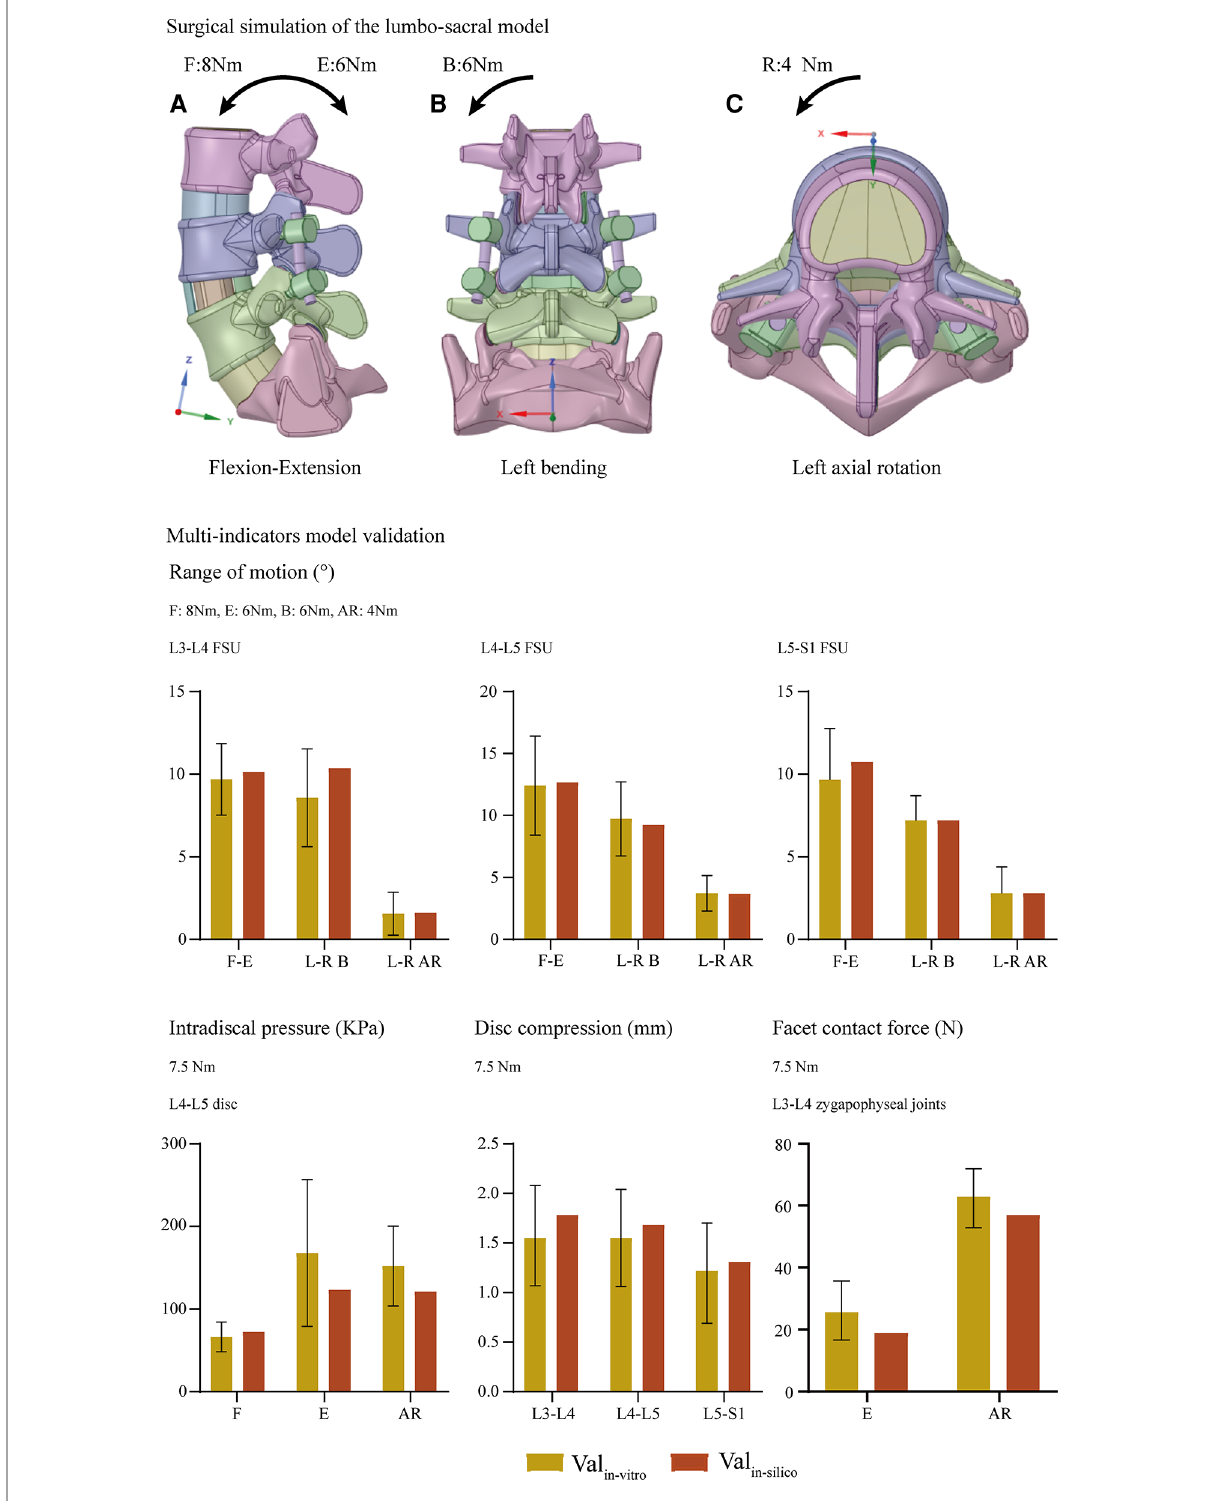
FIGURE 1 Surgical simulations and multi indicators model validation: Val in − vitro , indicators measured by published in-vitro studies; Val in − silico , indicators computed by the current in-silico study; F-E, fl exion-extension; L-R, left-lateral; B, bending; AR, axial